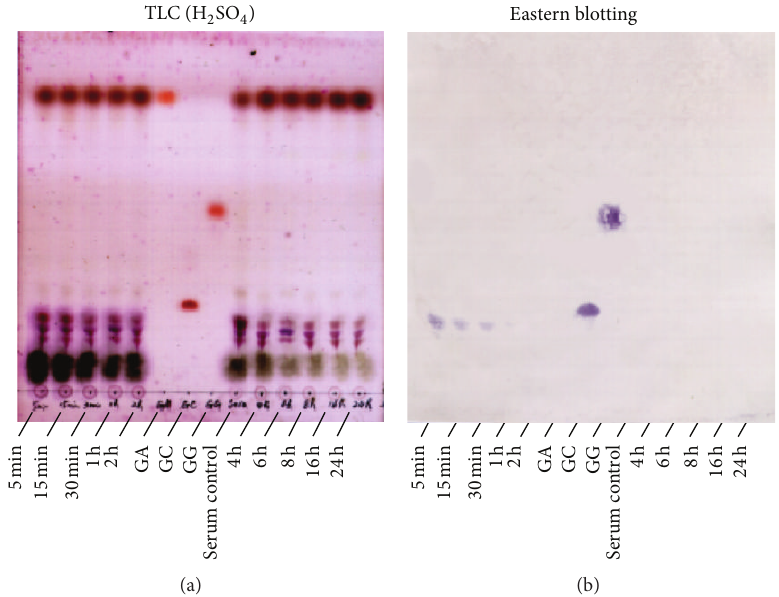
Figure 4: Chromatographic fingerprinting of glycyrrhizin after injection of glycyrrhizin in rat serum by TLC stained by H 2 SO 4 and eastern blotting. (a) TLC chromatographic fingerprinting stained by H 2 SO 4 . (b) Chromatographic fingerprinting by eastern blotting. GA, GC,